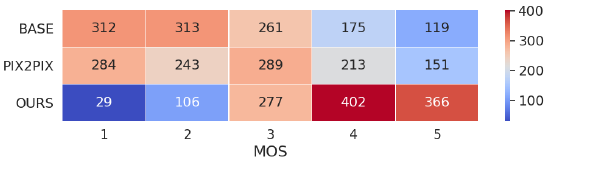
Figure 12. Heatmap of Mean Opinion Score